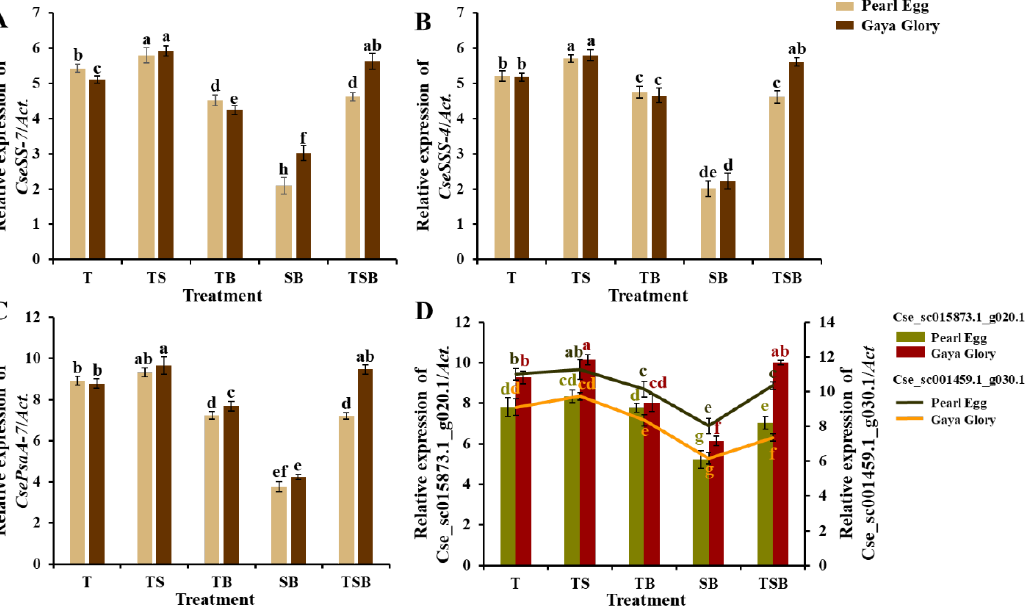
Figure 10. Changes in the gene expression levels in chrysanthemum “Pearl Egg” and “Gaya Glory” as affected by the different lighting direction combinations after 45 days of cultivation. Sucrose synthesis related genes: CseSS-7 ( A ). Starch synthesis related genes: CseSSS-4 ( B ). Photosynthesis-related genes: CsePsaA-7 ( C ). Flowering related genes: Cse_sc015873.1_g020.1 and Cse_sc001459.1_g030.1 ( D ). T, TS, TB, SB, and TSB, refer to the top (1/1), top (1/2) + side (1/2), top (1/2) + bottom (1/2), side (1/2) + bottom (1/2), and top (1/3) + side (1/3) + bottom (1/3) lighting, respectively. Vertical bars indicate the means ± standard error ( n = 6). Different lowercase letters indicate significant separations within treatments by Duncan’s multiple range test at p ≤ 0.05.